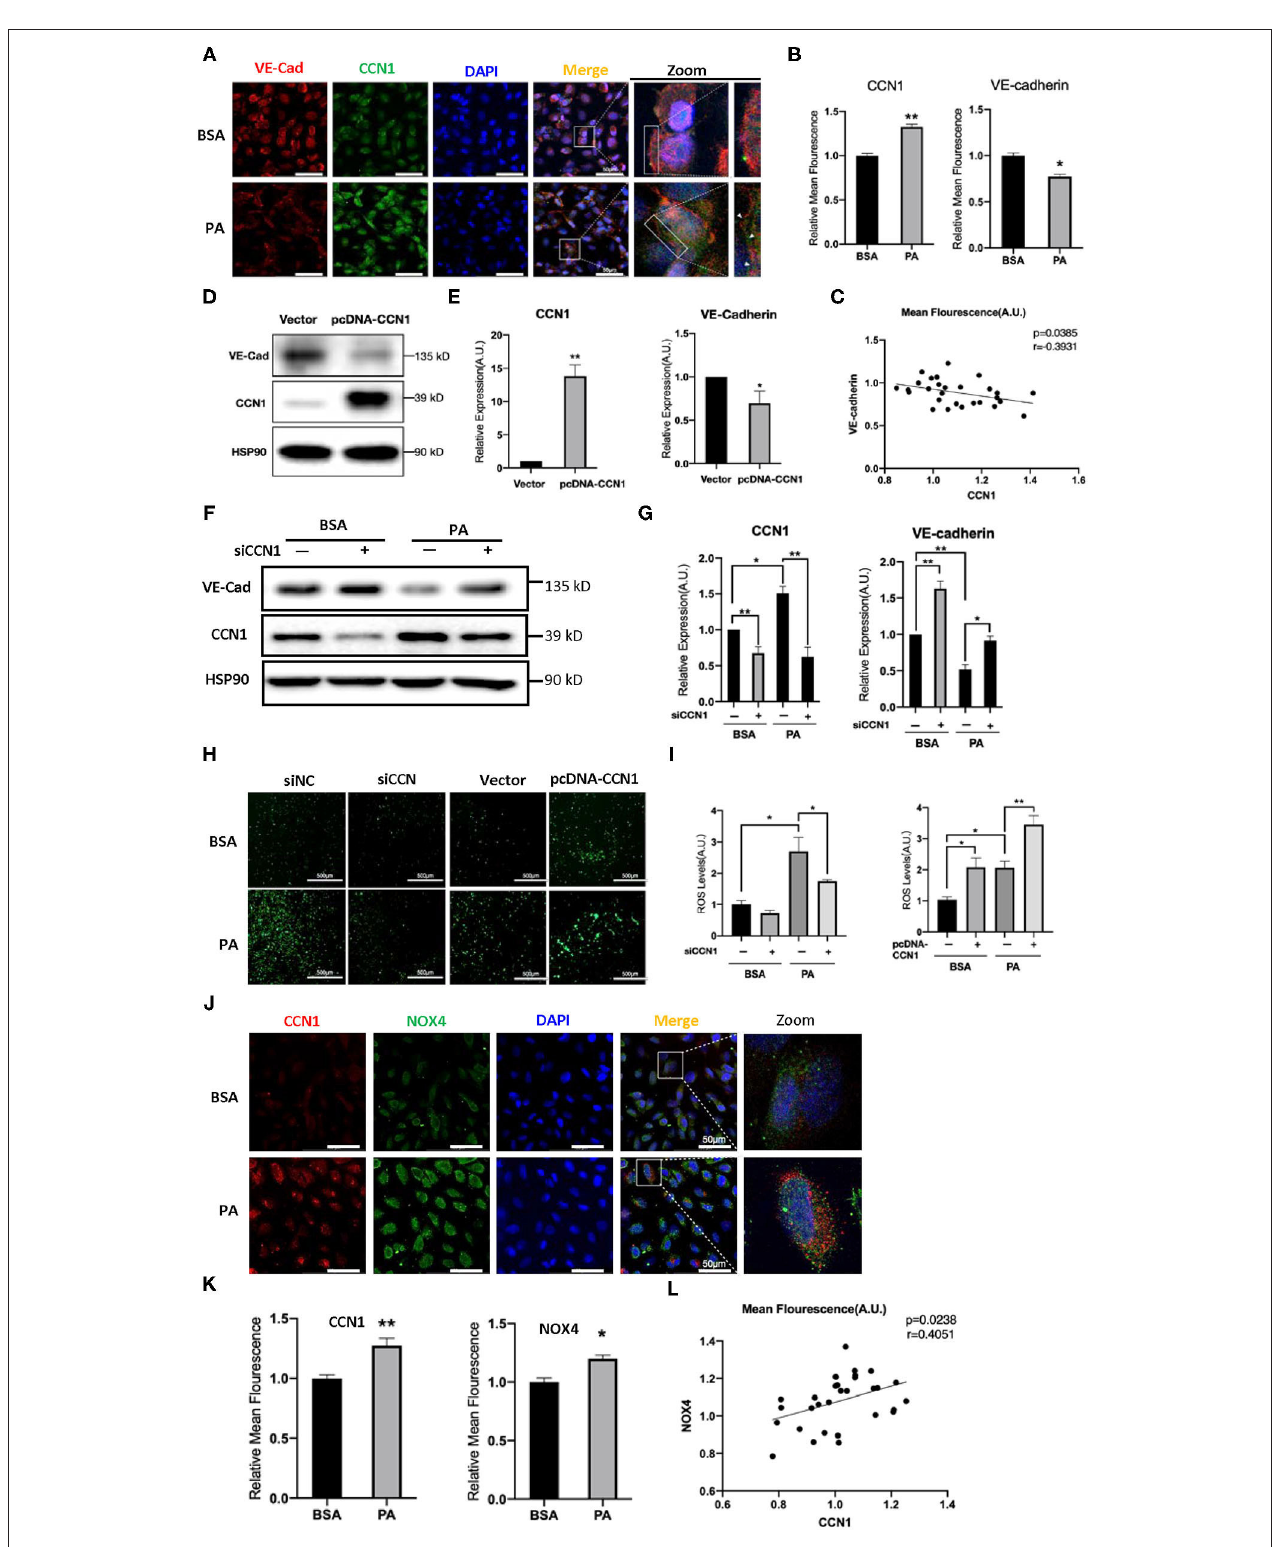
FIGURE 4 | CCN1 downregulates VE-cadherin by activating the NADPH oxidase (NOX4)/reactive oxygen species (ROS) axis. (A) Representative images, (B) mean density, and (C) relevance analysis of fluorescence of CCN1 and VE-cadherin in human retinal vascular endothelial cells (HRVECs). (A) White arrows indicate